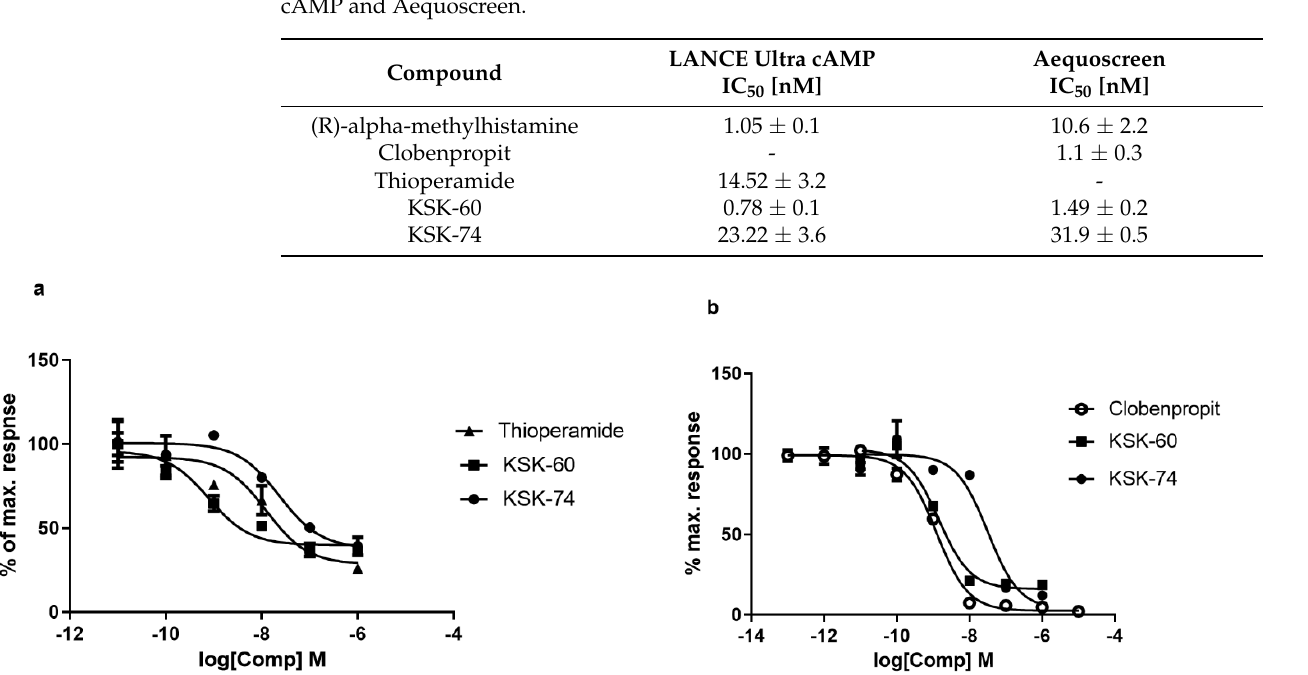
Figure 2. The intrinsic activity at the histamine H 3 receptor of the tested compounds presented as concentration-dependence curves. The values (%) obtained by two methods, LANCE cAMP ( a ) and Aequoscreen ( b ), are expressed as a percentage of the action of the full agonist (R)-alpha- methylhistamine at the dose of EC 80 (100%).